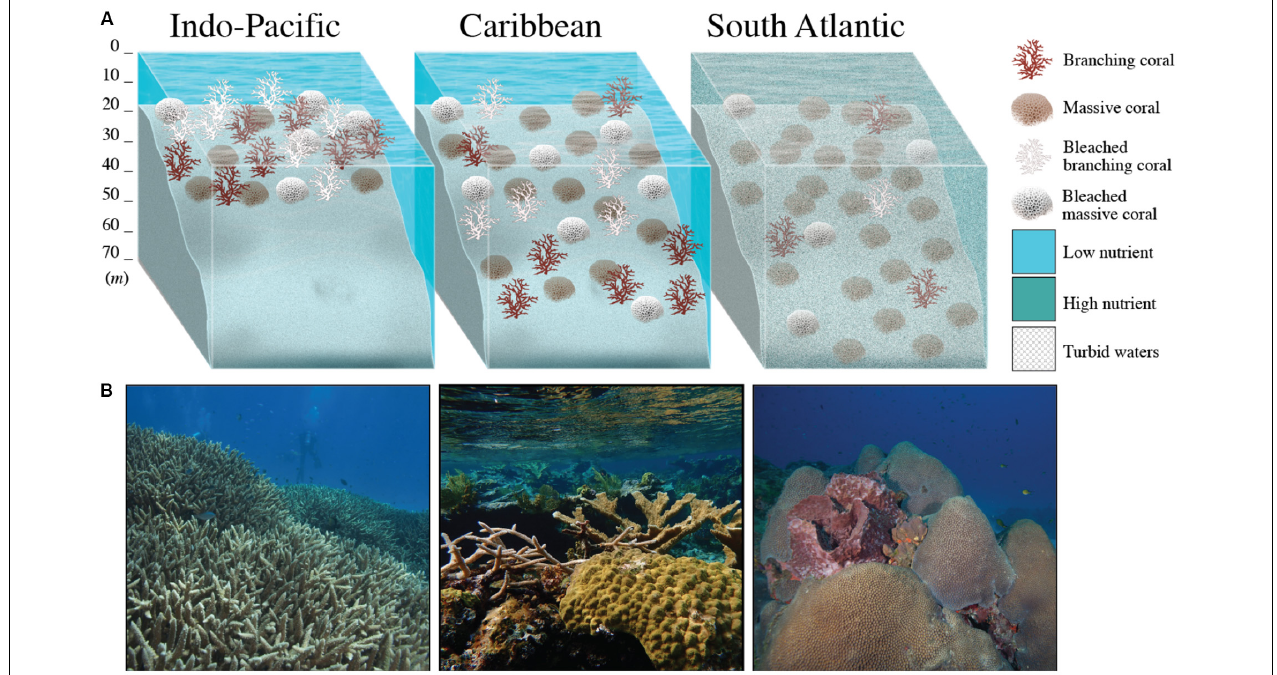
FIGURE 4 | General comparison of Indo-Pacific, Caribbean and South Atlantic reefs: (A) Depiction of main characteristics that make South Atlantic reefs more resistant: (i) deeper mean distribution limit for coral species, (ii) tolerance of coral species to turbid conditions, (iii) reefs found in higher nutrient conditions, (iv) predominance of massive coral species (with proportion of massive and branching forms displayed according to Figure 2 ), (v) prevalence of generalist corals and symbionts (not shown in figure), and (vi) lower incidence of severe bleaching episodes (with proportion of bleached colonies according to Figure 3 ). (B) In situ photographs of typical coral reef morphology in the Indo-Pacific (branching forms at Milln Reef, Great Barrier Reef), Caribbean (mixed branching and massive forms at Andros Island, Bahamas) and South Atlantic (massive forms at Fernando de Noronha Archipelago, Brazil).